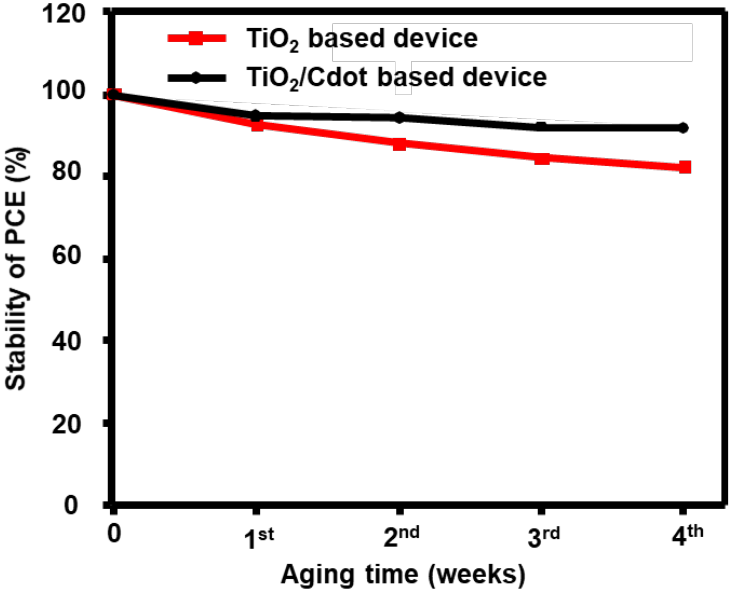
Figure 7. The stability of meso-TiO 2 and meso-TiO 2 /C-dot based